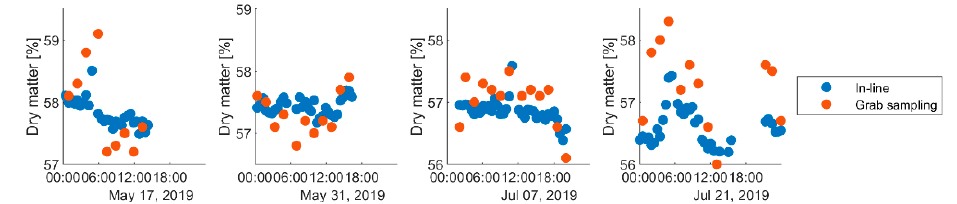
Figure 9. Estimates of batch means for four selected production days in 2019. Grab samples are taken from approximately every fourth batch. The estimates show the same trends, but variation is larger in grab samples. Table 3 sums up the precision in estimation of batch mean, based on simulated data. Table 3. Precision of batch mean estimates for different sampling regimes, evaluated by mean squared error (MSE) and R 2